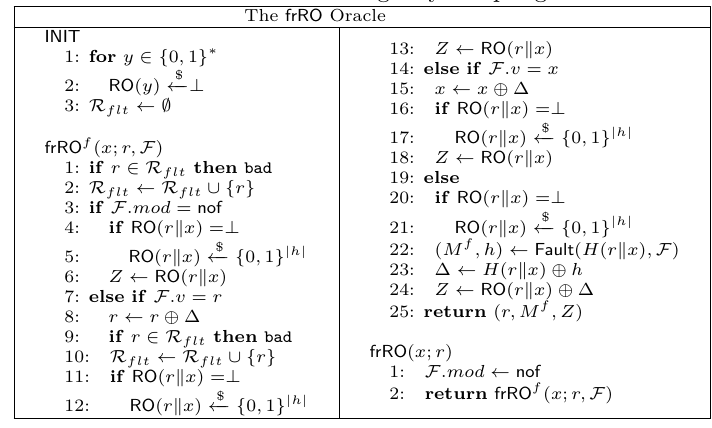
Table 5: frRO using lazy